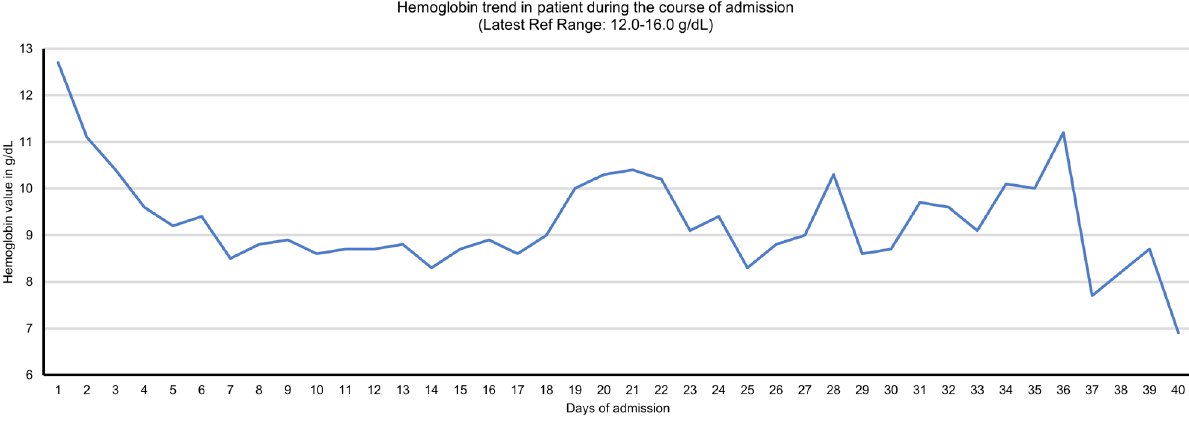
Her activated partial thromboplastin time (aPTT) was elevated to more than 100 seconds. This